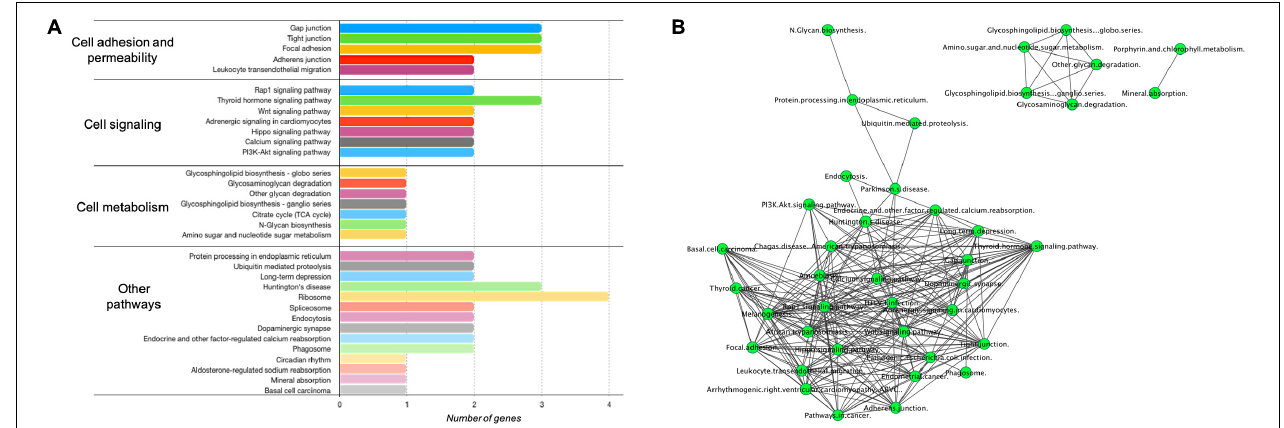
FIGURE 4 | Enriched pathways of protein-coding genes differentially expressed in human brain microvascular endothelial cells treated with γ -valerolactones. Differentially expressed protein-coding genes between VALs and TNF- α groups were used in a GeneTrial analysis to obtain the list of enriched pathways. (A) Histogram that shows the number of genes mapped to the enriched pathways classified in cell adhesion and permeability, cell signaling, cell metabolism and other pathways. (B) Pathway interactions network built in Cytoscape software to show the connections (edges) between enriched pathways (nodes) by differentially expressed protein-coding